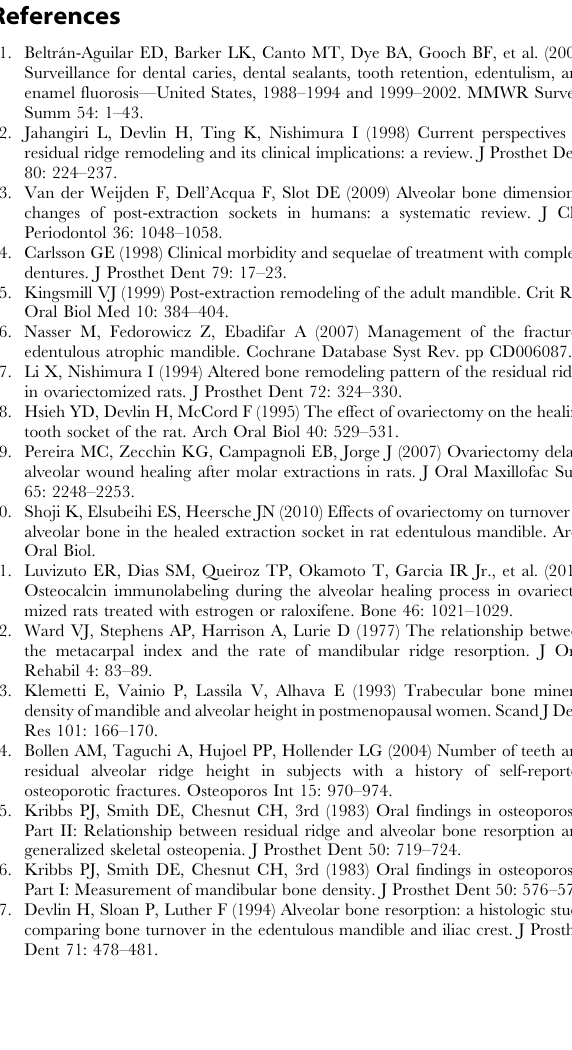
Table S1 The complete list of SNPs in the FGFR1OP2/wit3.0